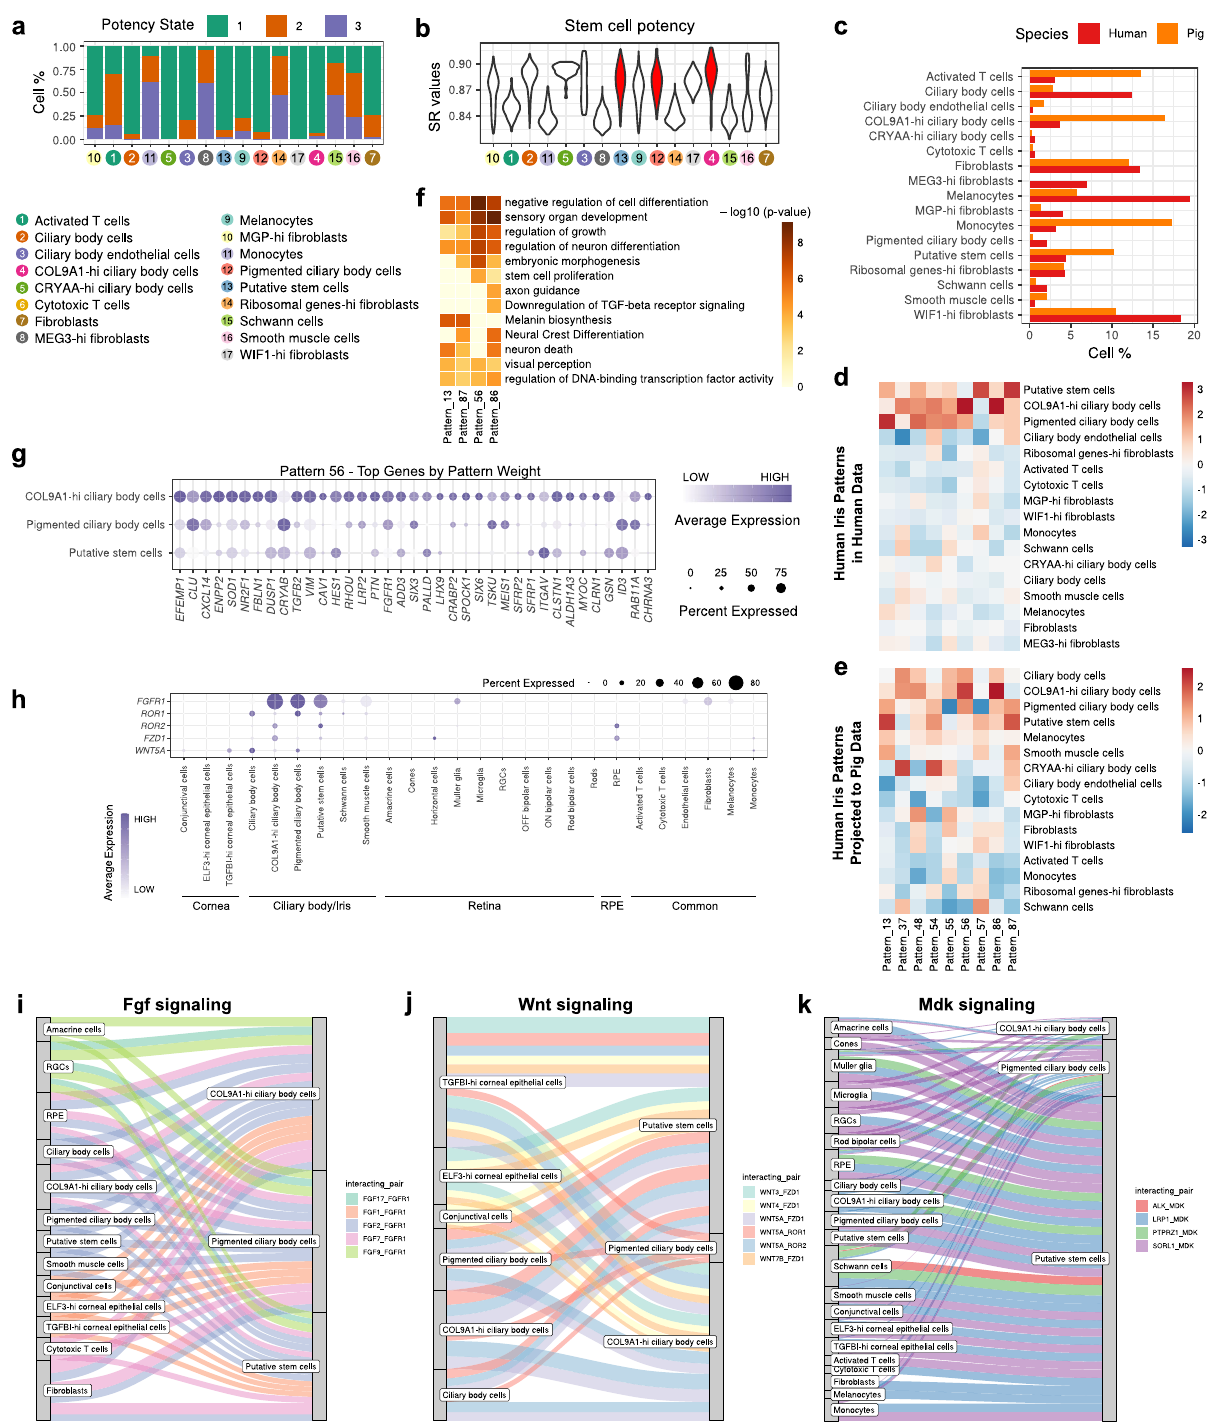
Fig. 4 Characterization of putative stem cells. a , b Stem cell potency of cell types in the iris region of the eye. The stem cell potency scores (SR values) and potency states were inferred using SCENT (see Supplementary Information). c Similar proportion of cell types in iris could be detected across a pig and human samples. d , e Patterns of gene expression as determined by scCoGAPS algorithm in iris cell types of the human eye ( d ) and projection of those patterns into pig iris cell types ( e ). Nine patterns highly correlated with either putative stem cells, COL9A1-high ciliary body cells or pigmented ciliary body cells were selected. f GO enrichment terms for patterns speci fi c to COL9A1 high ciliary body cells, pigmented ciliary body cells and putative stem cells. Metascape calculated the statistical signi fi cance of each GO term enrichment ( p -value) based on the accumulative hypergeometric distribution. The grey colour indicated a lack of signi fi cance. g Genes that make up the patterns speci fi c to COL9A1 high ciliary body cells. h Expression of receptors speci fi c to putative stem cells, pigmented ciliary body cells and COL9A1-hi ciliary body cells. i – k Interaction map between FGFs ( i ), WNTs ( j ), and MDK ( k ) secreted by several cell types with stem cells in the eye, respectively. Edge weights represent the probability of signalling between cell